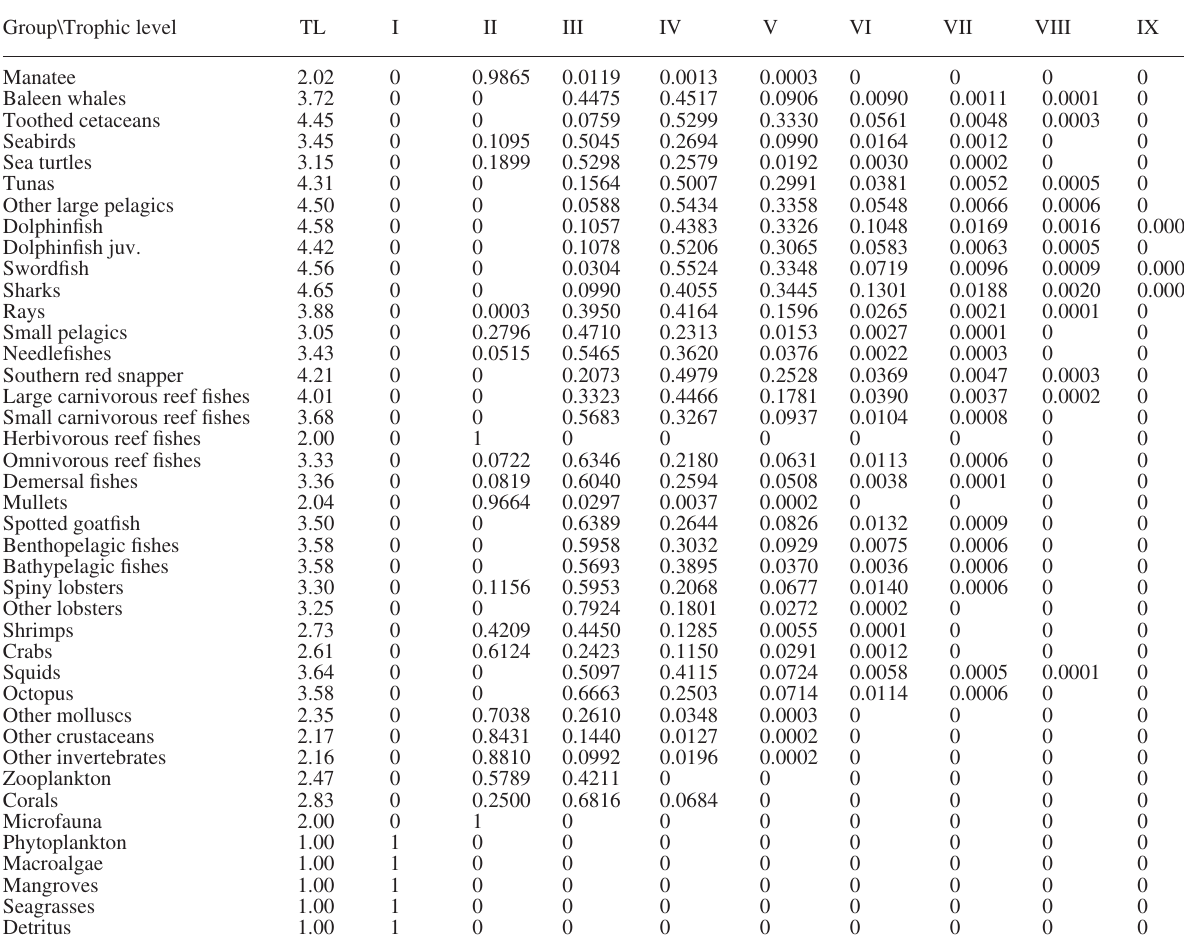
Table 4. – Relative flows by discrete trophic level for the marine ecosystem off northeastern Brazil in the 1970s model. Flows through the trophic level X are too low to be shown. TL represents the fractional trophic level sensu Odum and Heald (1975). Group\Trophic level